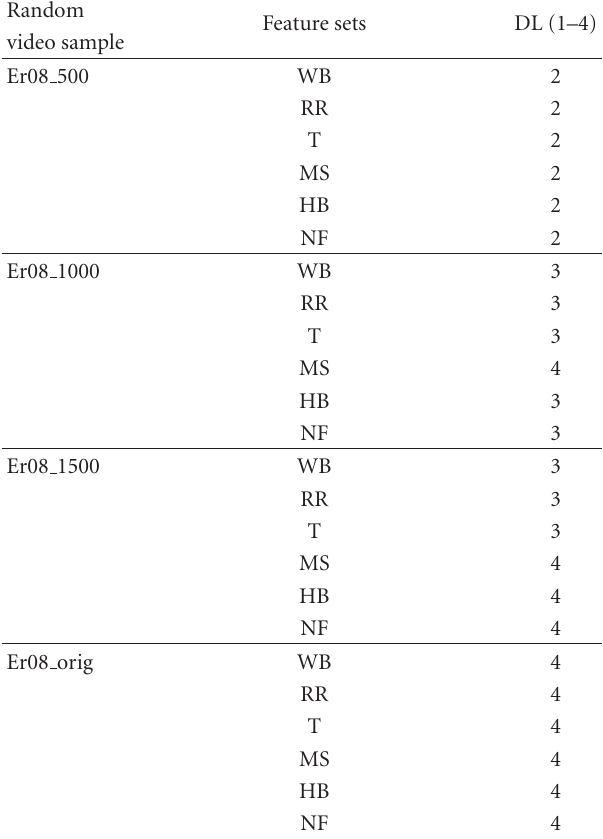
Table 2: Evaluation of video Er08 compressed at four di ff erent compression levels (diagnostic level quality scale: 1-no, 2-maybe not, 3-likely, 4-yes).